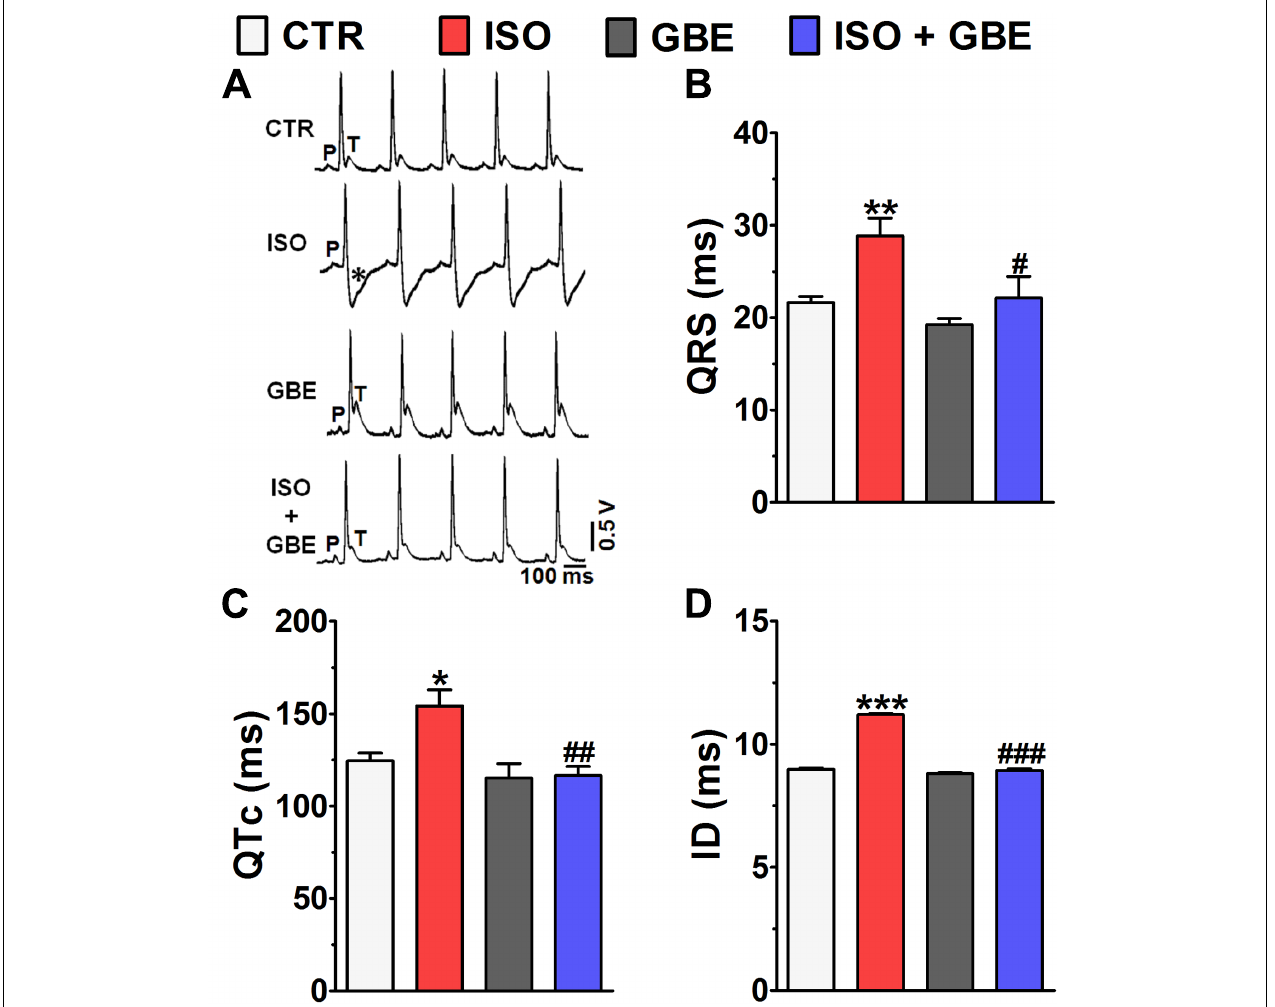
FIGURE 6 | Ginkgo biloba extract prevents typical electrocardiographic changes of cardiac hypertrophy. (A) Representative ECG recordings of four experimental groups. Asterisk indicates ST segment depression with a negative T-wave. Bar graph shows that GBE prevented increases in the (B) QRS complex, (C) QTc, and (D) intrinsicoid deflection (ID) interval. Data are represented as means ± SEM, ( n = 14). ∗ p < 0.05, ∗∗ p < 0.01, and ∗∗∗ p < 0.001 vs. CTR; # p < 0.05, ## p < 0.01, and ### p < 0.001 vs. ISO, one-way ANOVA followed by Bonferroni’s